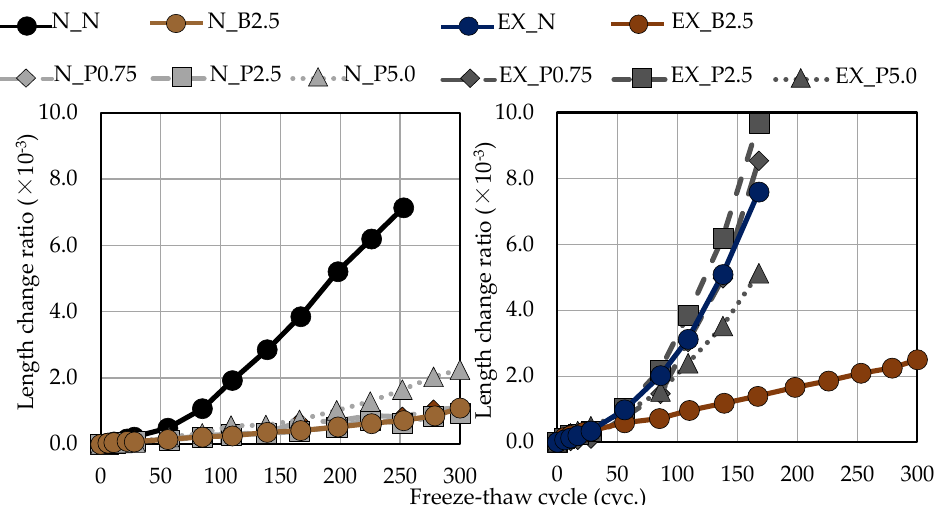
Figure 11. Relationship between length change ratio and the freeze-thaw cycle in ordinary and expansive mortars. (black: without NFBC, brown: with NFBC type B f , grey: with NFBC type P f ).